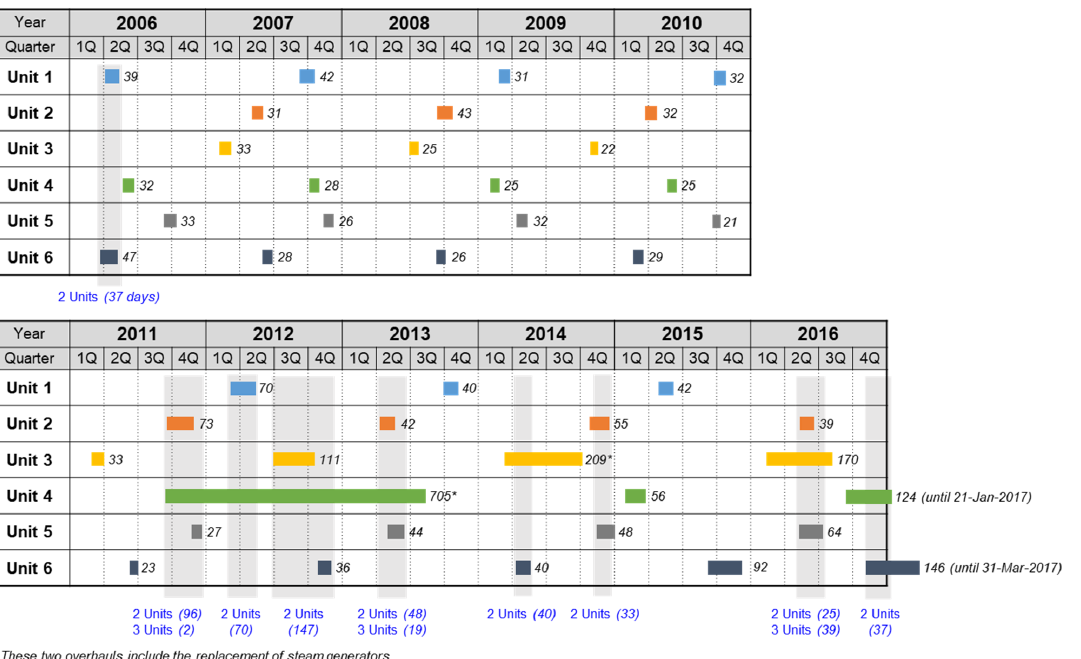
Table 2. Fraction of time for each number of units in O/H.